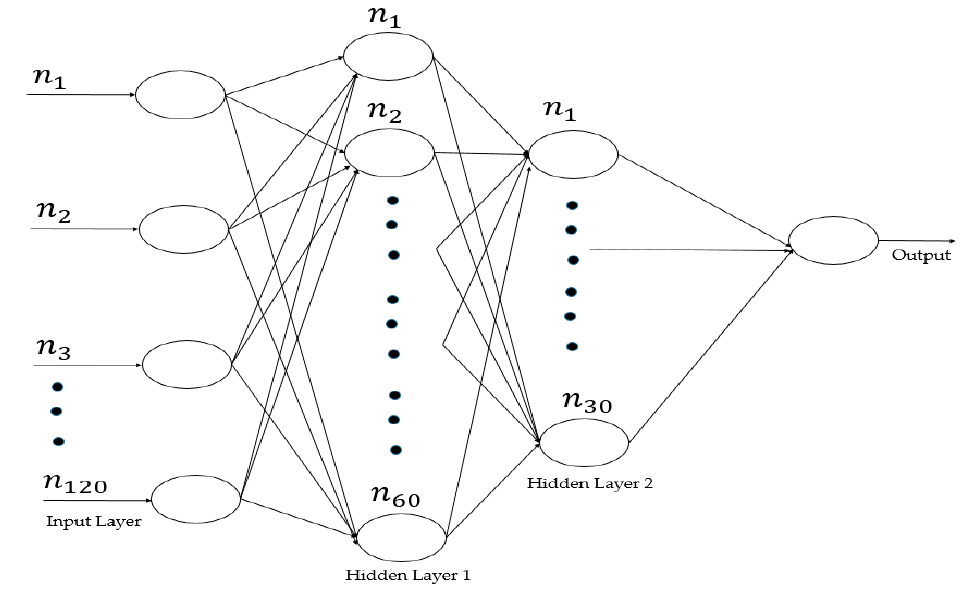
Figure 2. Proposed neural network architecture.